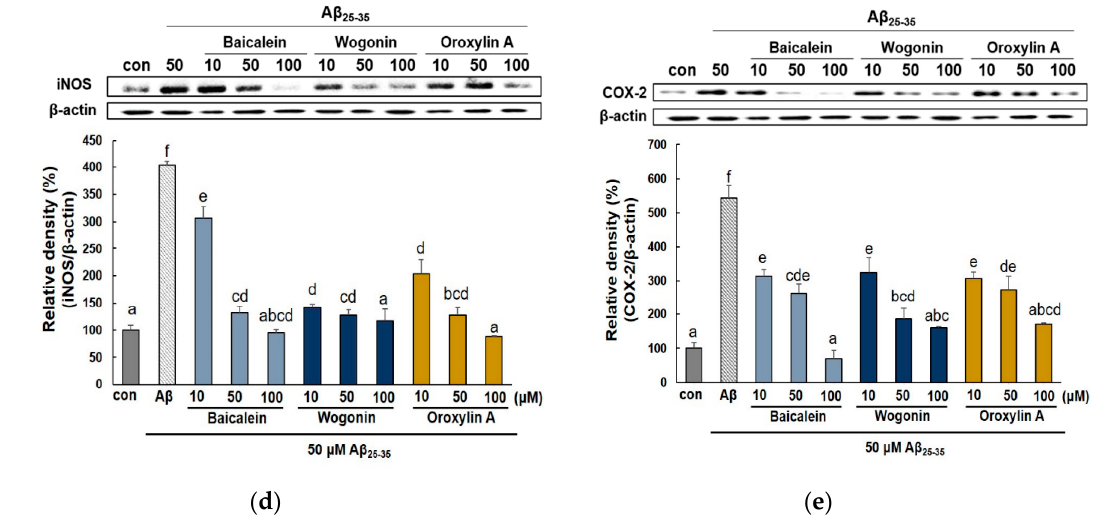
Figure 7. Effect of baicalein, wogonin, and oroxylin A on the production of proinflammatory cytokines and their protein expressions in A β 25–35 -induced PC12 cells. The cells were pretreated with samples for 1 h, and stimulated with A β 25–35 for 24 h. The media were collected to assess the production of no and PGE 2 . The expression of TNF- α ( a ), iNOS ( d ), and COX-2 ( e ). NO levels were assessed by Griess assay ( b ). PGE 2 levels in supernatants were determined by ELISA assay kit ( c ). The PC12 cells were incubated with samples and then treated with A β 25–35 for 24 h. The cells were lysed and the protein levels were quantified using the BCA assay. Different alphabets indicated significant difference at p < 0.05.